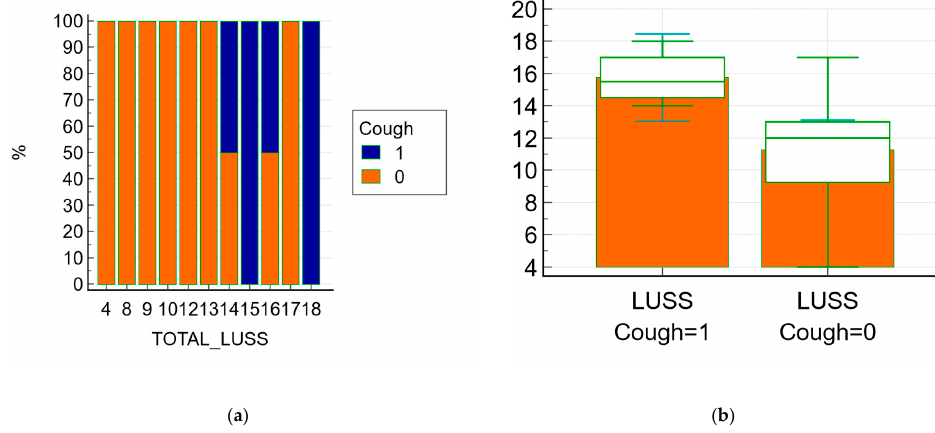
Figure 5. The relationship between symptoms (cough) and LUSS; 1 means present/affirmative and 0 means absence/negative ( a ) the frequencies chart of the Chi-squared test with a graph with a 100% stacked column; ( b ) Box-and-whisker of data comparison between LUSS at neonates with cough and LUSS at neonates without.